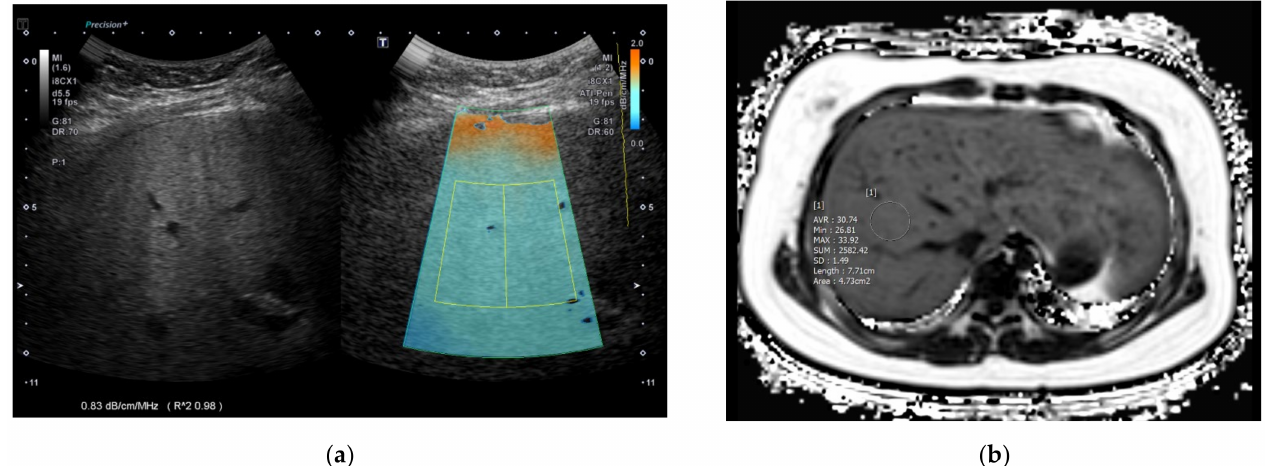
Figure 2. An 11-year-old girl in the moderate to severe fatty liver group according to grayscale US. ( a ) The ATI value was 0.83 dB/cm/MHz and ( b ) MRI-PDFF value was 30.7% (S3: PDFF > 23.3%). US: ultrasonography; ATI: attenuation imaging; MRI: magnetic resonance imaging; PDFF: proton density fat